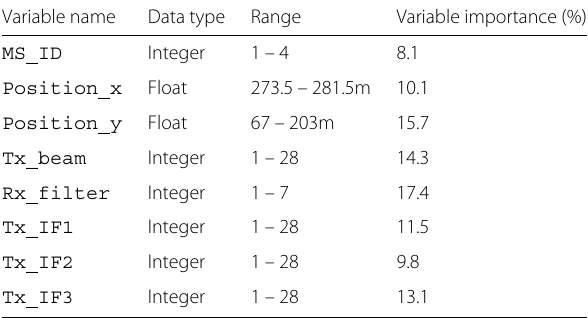
Table 1 Properties of the input variables